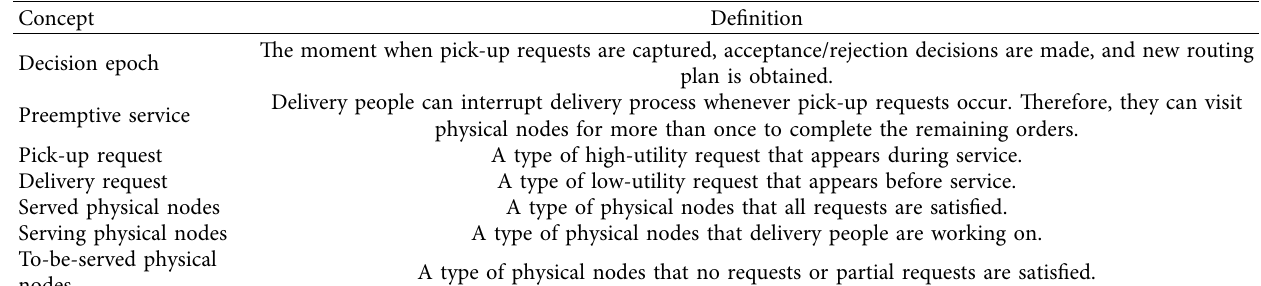
Table 17: Definitions of some key modeling